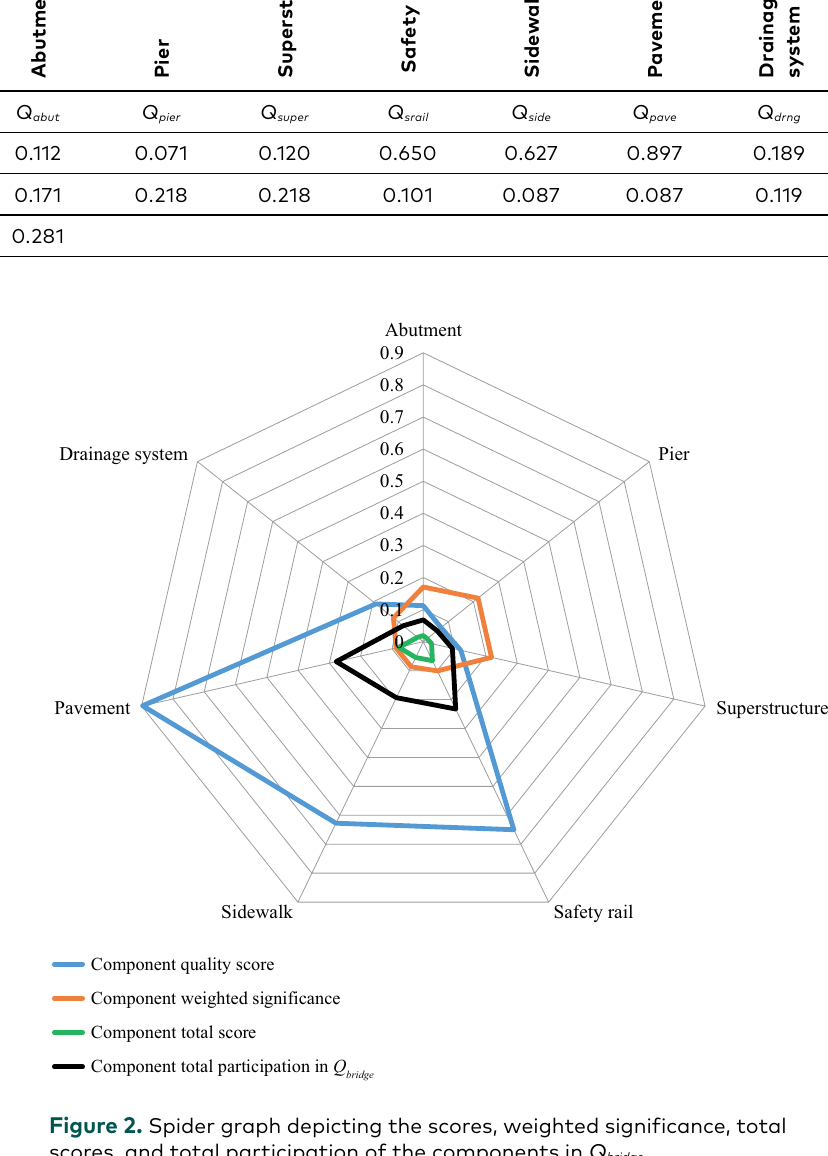
Figure 2. Spider graph depicting the scores, weighted significance, total scores, and total participation of the components in Q